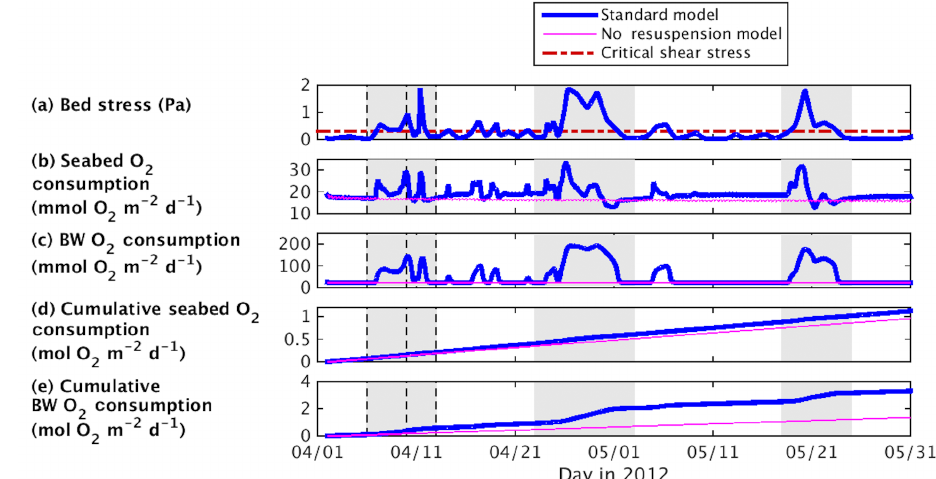
Figure 4. Time series of bed stress and oxygen consumption in the seabed and bottom water (BW) for both the standard (blue solid line) and no-resuspension model runs (pink line). Shading indicates resuspension events, i.e., cycles of erosion and redeposition, as listed in Fig. 3. The red dashed line indicates the critical shear stress for erosion, and the black dashed lines indicate the times at which profiles in Fig. 5 were